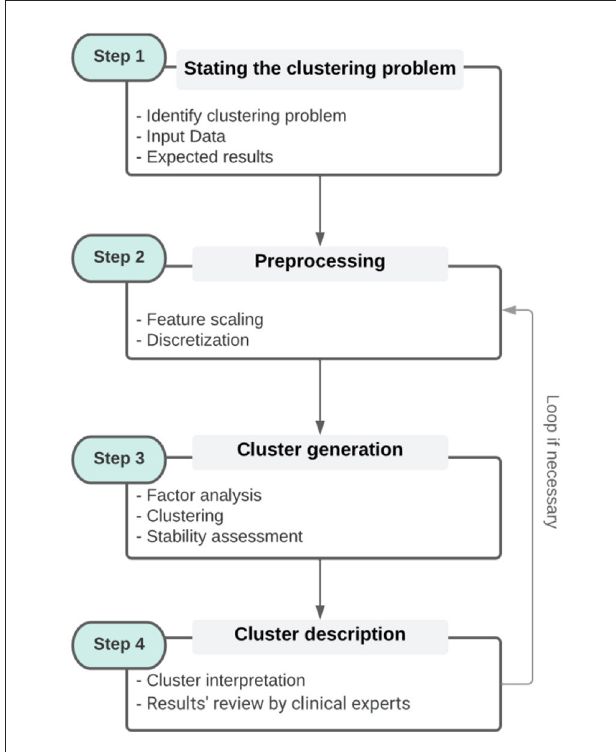
FIGURE1 The general clustering process [It is broken down into four steps. Step 1 corresponds to the identification of the problem and the collection of data. Step 2 is a pre-processing step that includes the different transformations of the data. Step 3 is the clustering of the data itself, while step 4 is the interpretation of the clusters with respect to the original data. The contents of each box (steps) are examples and not sub-steps that must be